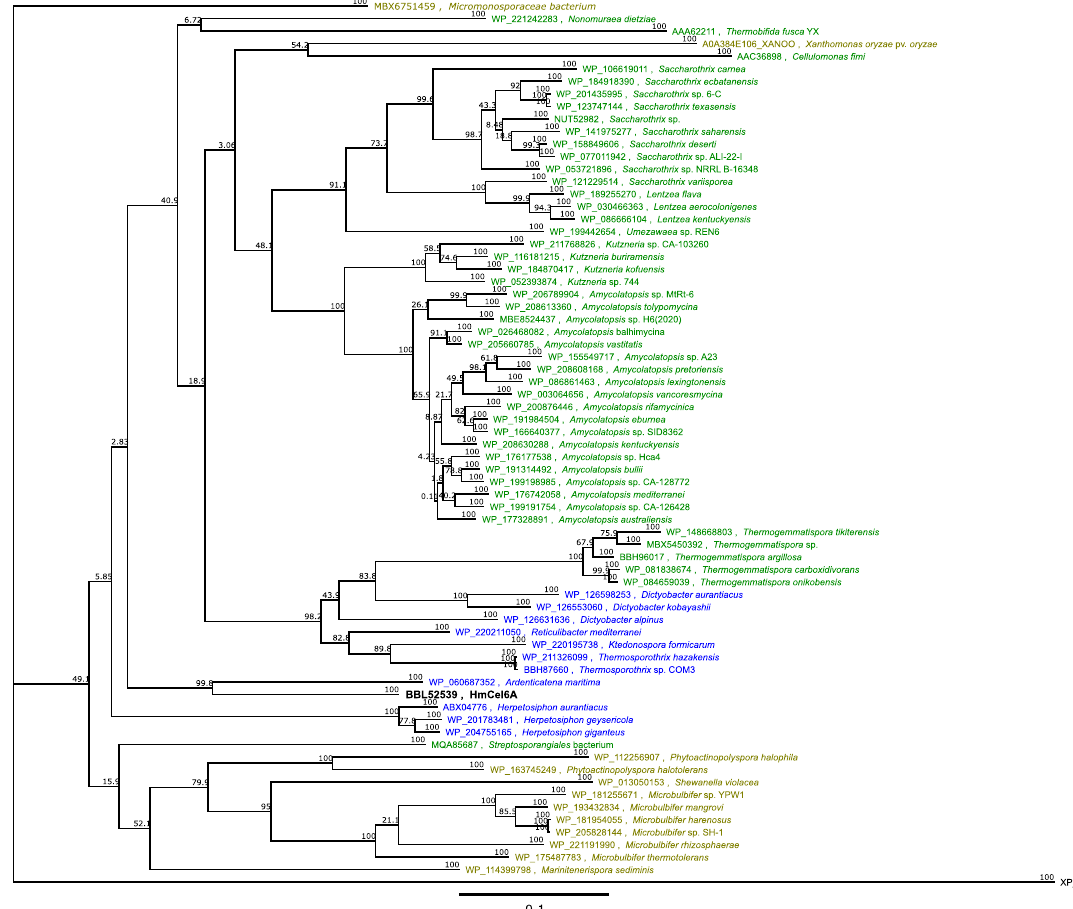
Fig. 1 Non-rooted phylogenetic tree of bacterial GH family 6. Bootstrap values at branch points are indicated for 10,000 replicates and shown as percentages. Scale bar = 0.1 amino acid substitutions per site. Branches corresponding to partitions that were reproduced in <50% of bootstrap replicates are collapsed. The tree is drawn to scale, with branch lengths in the same units as those of the evolutionary distances that were used for phylogenetic tree construction. The sequences of three bacterial structure-determined CBHs and CBH II from Trichoderma reesei ( Hypocrea jacorina ) were also included. Species belonging to high G + C Gram-positive bacteria, green non-sulfur bacteria and γ -proteobacteria are colorised with green, blue and olive,